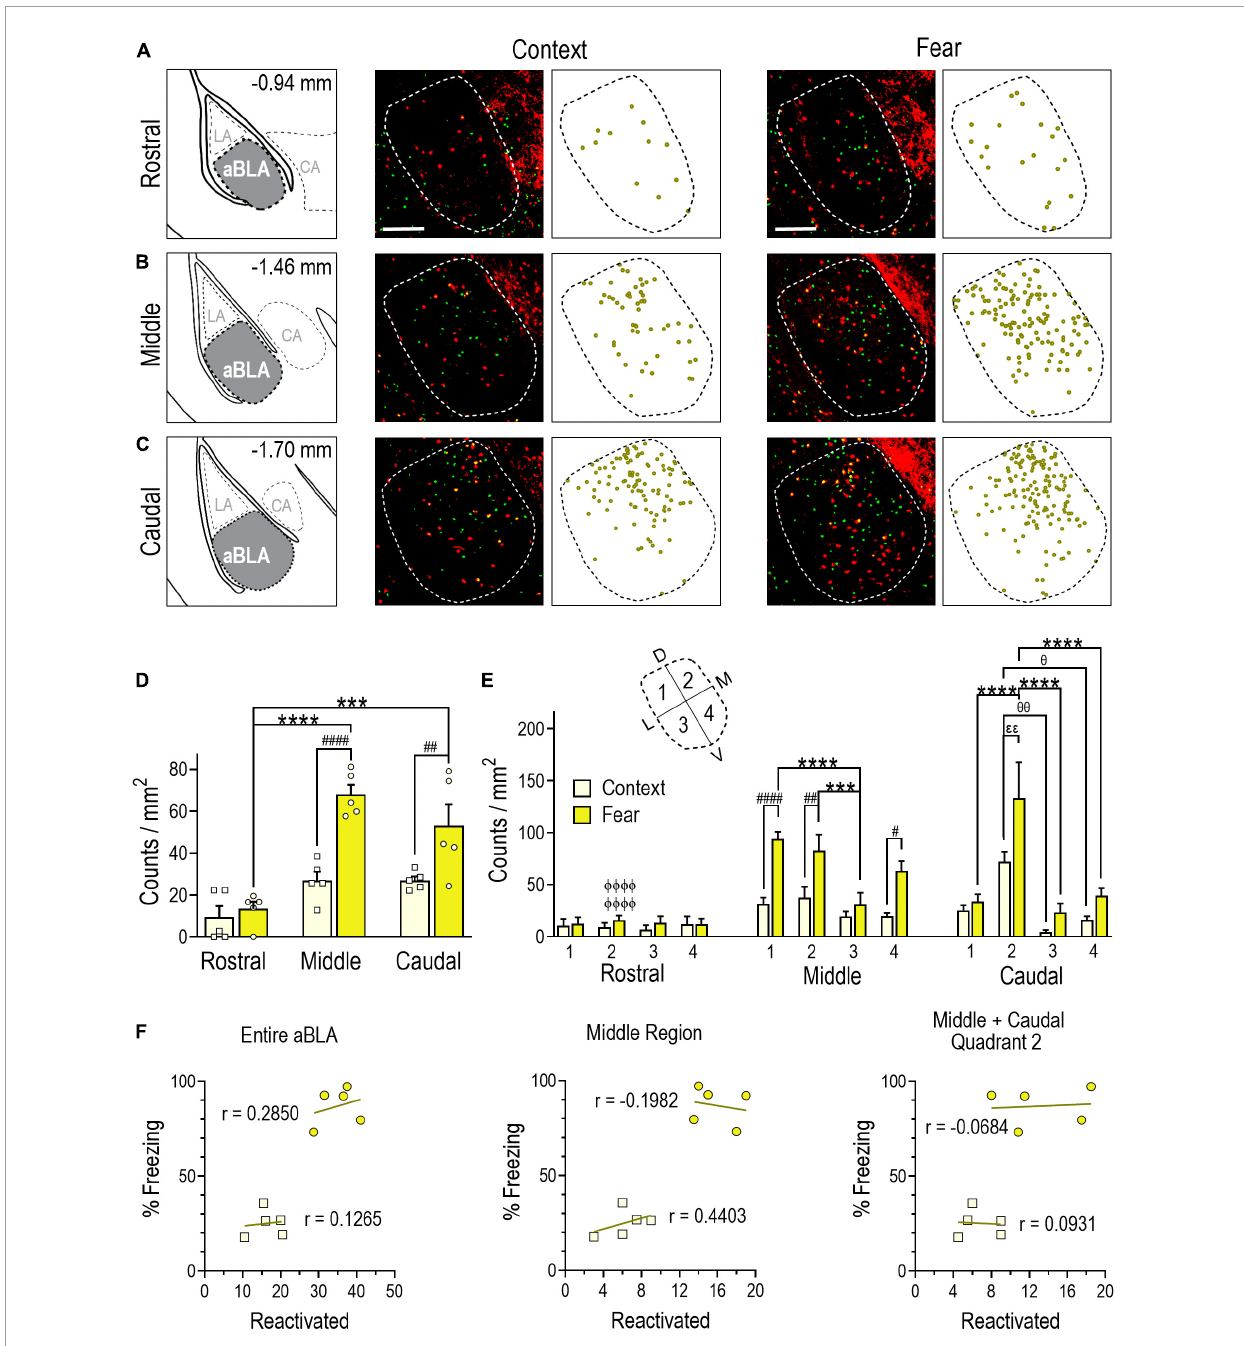
FIGURE4 Evidence of a remote contextual fear memory engram in the aBLA. (A–C) Stereotaxic plate drawings of aBLA sub-regions (left), representative images of neurons reactivated + (yellow, tdTomato + and Fos +) during remote contextual memory recall and their summary distribution plot (center, n = 5 mice), and representative images of neurons reactivated (yellow, tdTomato + and Fos +) during remote contextual fear memory recall and their summary distribution plot (right, n = 5 mice). (A) Rostral sub-region. (B) Middle sub-region. (C) Caudal subregion. Scale bar (top, left) = 200 µ m. (D) Average density of reactivated neurons in each analyzed aBLA sub-region in context and fear groups. ## P = 0.0098, #### P < 0.0001 between groups. *** P = 0.0001, **** P < 0.0001 between sub-regions in the fear group. Two-way ANOVA with Sidak’s post-test. (E) Distribution of reactivated neurons in quadrants (inset) of the rostral, middle, and caudal aBLA. Middle: # P = 0.0129, ## P = 0.0072, #### P < 0.0001 between groups; *** P = 0.0009, **** P < 0.0001 between quadrants in the fear group. Caudal: εε P = 0.0120 between groups; θ P = 0.0292, θθ P = 0.0023 between quadrants in the context group, **** P < 0.0001 between quadrants in the fear group. φφφφ P < 0.0001 between sub-region and within-fear and within-quadrant. Three-way ANOVA with Tukey’s post-test. Data are mean ± SEM. (F) Correlations showing the relationship between the amount of time mice spent freezing during remote context memory (squares) or fear memory (circles) recall and reactivation counts (tdTomato + and Fos +) in the entire aBLA (left), its middle sub-region (center) and in quadrant 2 of the middle and caudal sub-regions (right). In each graph, lines represent the least squares regression for each correlation. Within each treatment group, Pearson’s coefficients (r) were not significant for any correlation. Between groups, Fisher’s z transformation was applied and coefficients (r’) were not different between groups for any correlation (see Supplementary Table 1